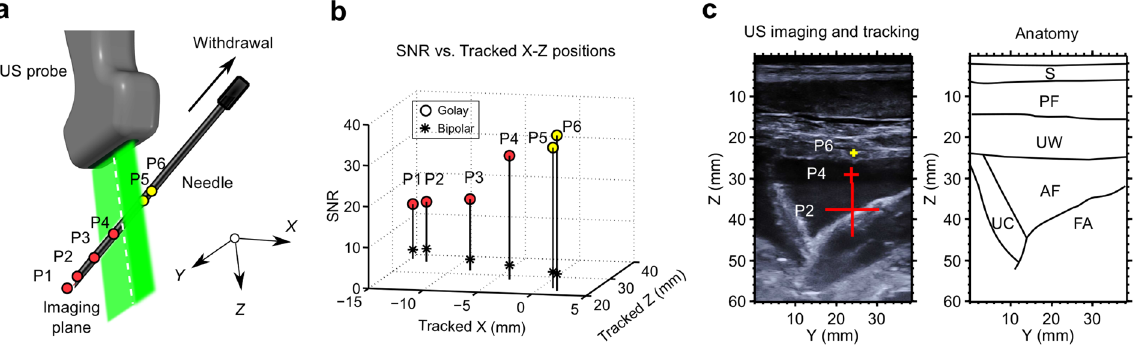
Figure 5. Needle insertion into the uterine cavity of a pregnant sheep in vivo with concurrent 3D tracking. ( a ) Tracked needle tip positions (circles: P1-P6) obtained during withdrawal of the needle, displayed as they are in Fig. 4. ( b ) The signal-to-noise ratio (SNR) of the decoded US signals at the needle tip tended to increase with proximity to the imaging plane. ( c ) The tracked positions were overlaid with crosses onto a 2D US image (left) acquired with the central array of transducer elements, with the size of the cross (end-to-end of each line) scaled to represent the out-of-plane distance (for clarity, only 3 positions out of 6 are shown). The crosses were coloured (red/yellow) according to the side of the imaging plane in which the needle tip resided. Key anatomical features are depicted with outlines (right). S: skin; PF: percutaneous fat; UW: uterus wall; AF: amniotic fluid; UC: umbilical cord; FA: foetal